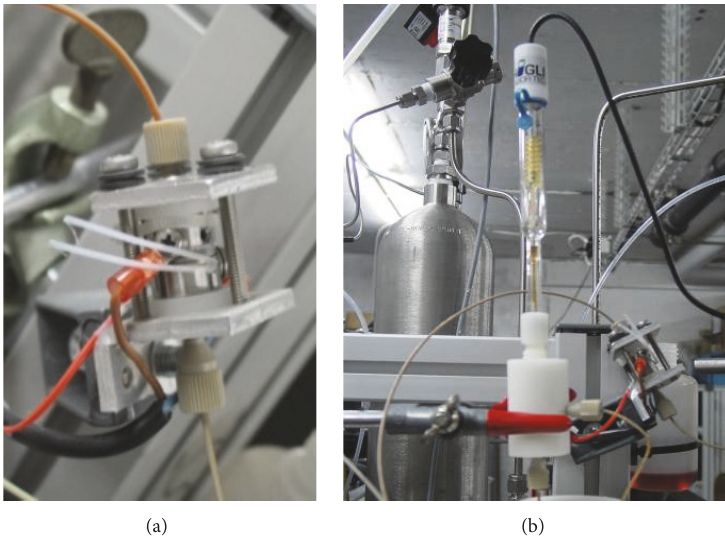
Figure 2: Flow-through cells for (a) electric conductivity and (b) pH.